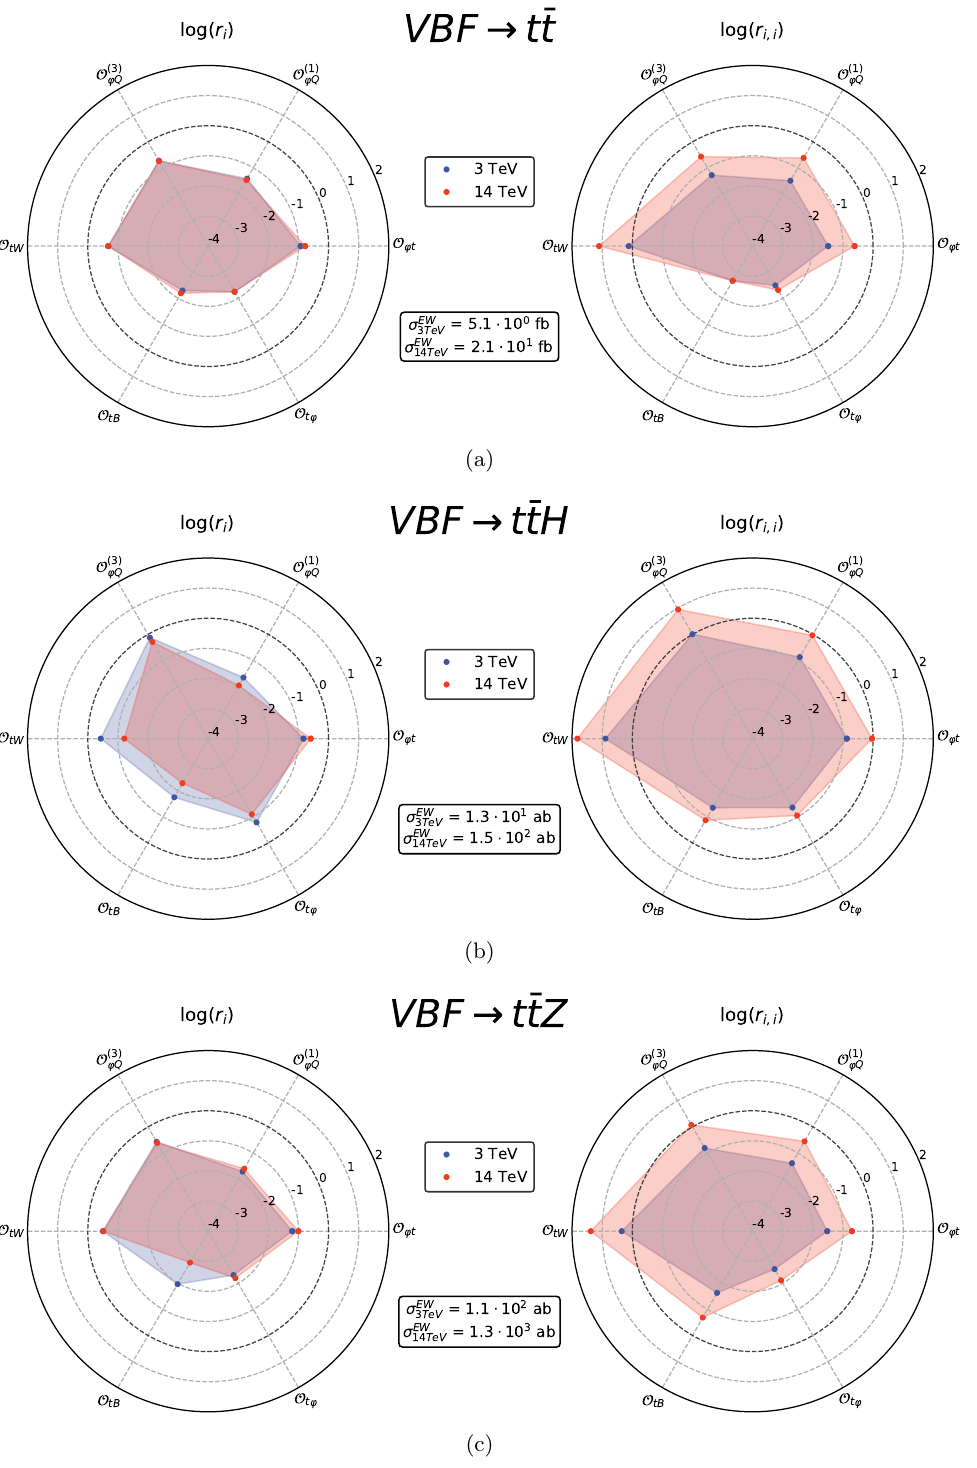
Figure 8 . Impact of dimension-six operators (polar direction) on (left) the interference term j r i j and (right) the quadratic term r i;i (radial direction in logarithmic scale) from the ratio R in equation (5.10) for the EW VBF ! t (cid:22) t ( H=Z ) processes at a lepton collider of dots) and 14 TeV (red dots), assuming a Wilson coe(cid:14)cient of 1 TeV (cid:0) 2 .